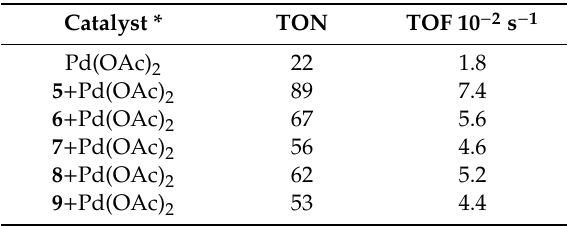
Table 2. (TON) and turnover frequency (TOF) values for coupling of 1-bromo-4-nitrobenzene with phenylboronic acid using different catalytic systems.